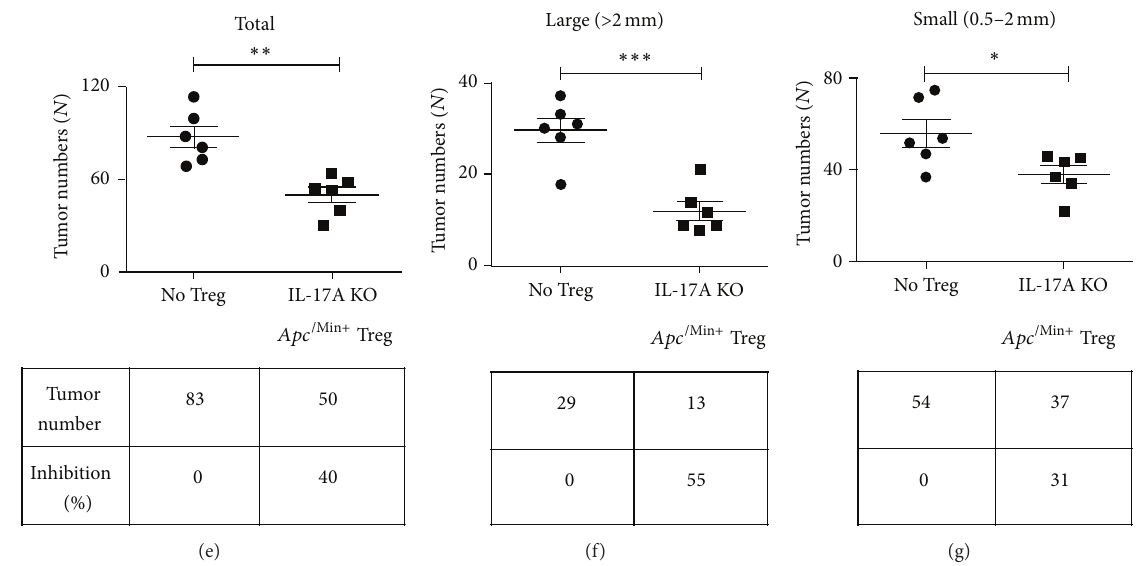
Figure 3: The heterozygous Apc gene mutation in Treg alone does not impair Treg-mediated tumor regression. (a–c) 4 × 10 5 CD4+Foxp3+ cells were isolated from 6-7-week-old 𝐴𝑝𝑐 Min /+ -FIR mice, their wild type littermate controls (FIR mice), and Foxp3-Cre ; 𝐴𝑝𝑐 flox /+ mice by cell sorting and then transferred to 3-month-old 𝐴𝑝𝑐 Min /+ mice. Tumor numbers were measured 4 weeks after adoptive transfer. Large tumors ( > 2.0mm) and small tumors (0.5–2.0 mm) were counted. (d) Tumors ( > 2.0mm) from each group of mice were excised and analyzed by real time PCR. Each group had more than 5 polyps analyzed. mRNA expression was normalized against HPRT for their relative expression level (HPRT = 1). (e–g) 4 × 10 5 Tregs from 6-7-week-old IL-17A deficient (KO)- 𝐴𝑝𝑐 Min /+ mice were transferred to 3-month-old 𝐴𝑝𝑐 Min /+ mice ( 𝑛 = 6 per group). Tumor numbers were measured 4 weeks after adoptive transfer. Data are shown as mean ± SEM. For (a–c), one-way ANOVA analysis with Bonferroni’s post hoc test was used. For other analyses, two-tailed 𝑡 -tests were performed for all groups. ∗∗∗ 𝑝 < 0.0005 ; ∗∗ 𝑝 < 0.005 ; ∗ 𝑝 < 0.05 ; n.s.: not